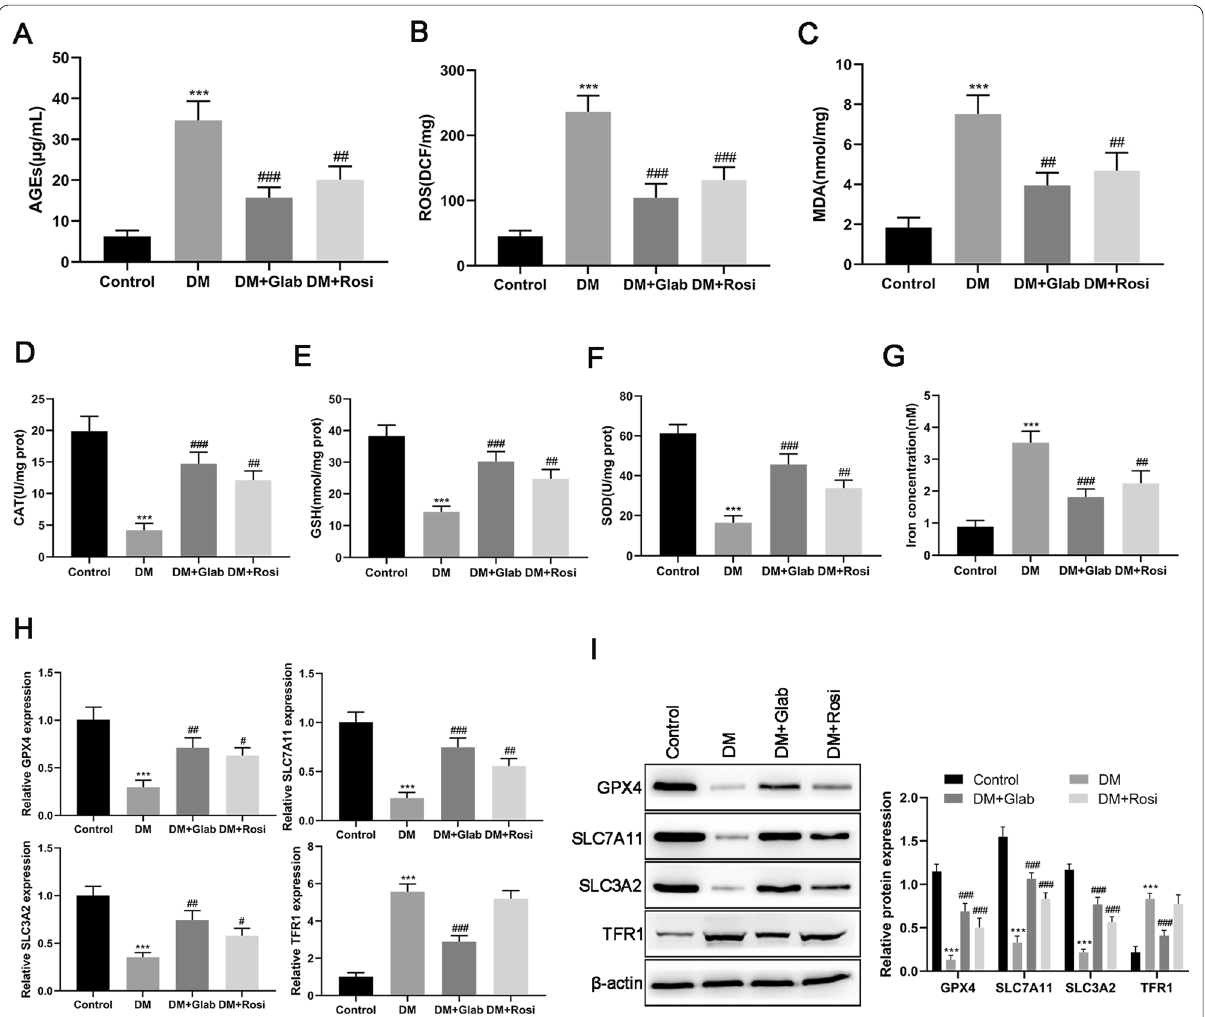
Fig. 5 - Effects of Glab on the level of oxidative stress associated parameters, AGEs, and ferroptosis markers in the kidneys of the DM rats. The levels of ( A ) advanced glycation end products (AGEs), ( B ) reactive oxygen species (ROS), ( C ) malondialdehyde (MDA), ( D ) catalase (CAT), ( E ) glutathione (GSH), ( F ) superoxide dismutase (SOD), and ( G ) iron concentration determined by commercial kits. The expression of ferroptosis markers (GPX4, SLC7A11, SLC3A2, and TFR1) at ( H ) mRNA and ( I ) protein levels were detected by RT-qPCR and western blot, respectively ( *** P < 0.005, vs. the control group; ## P < 0.01 and ### P < 0.005, vs. the DM